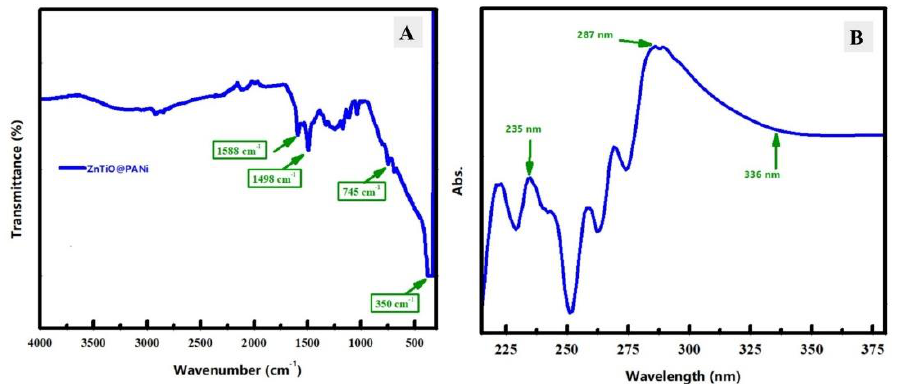
Figure 3. ( A ) FT-IR spectroscopy of the investigated ZnTiO@PANi composite, ( B ) UV – visible spec- troscopy in the aggressive solution of the examined ZnTiO@PANi composite.